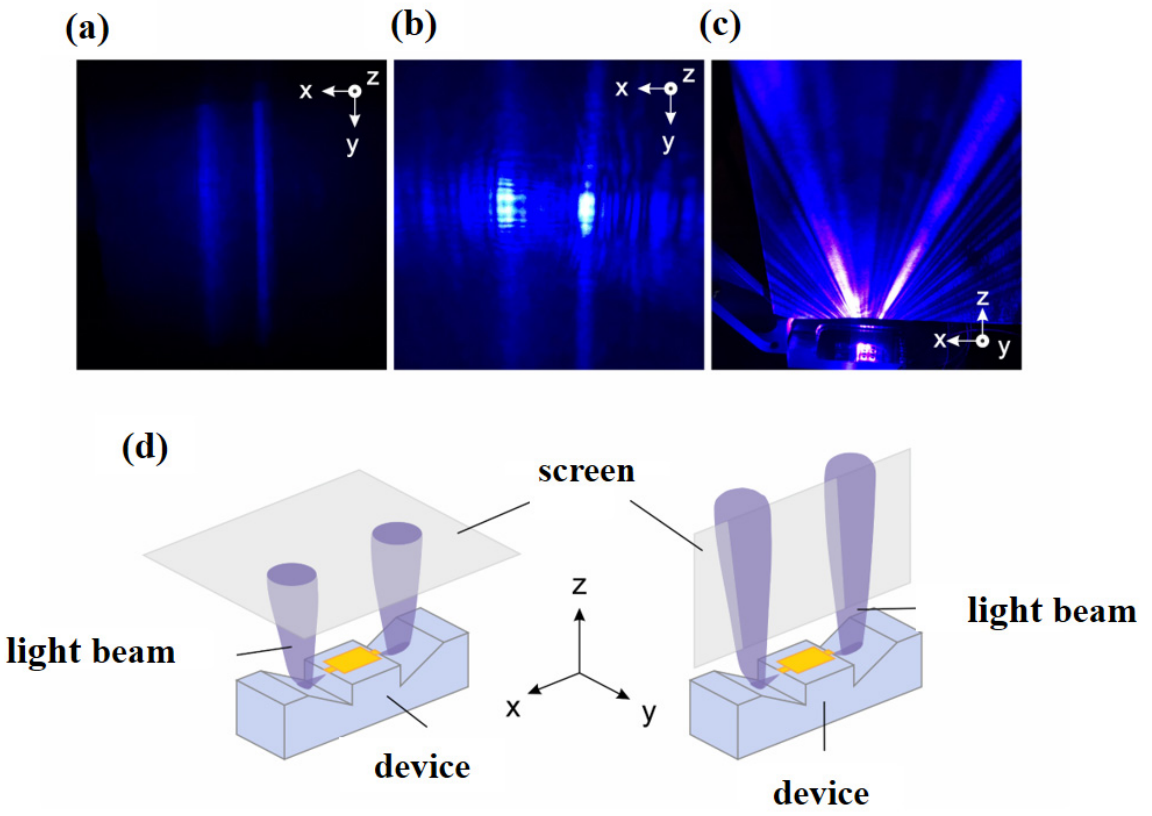
One can see from Figure 11b that in order to keep the center of the output beam within +/ − 10° from the vertical direction, the orientation of the deflecting mirror has to be retained between 40° and 50°. The experimental result presented in Figure 10c showing ror was different from the intended value. Figure 10. Photographic images show the direction of beam emission, ( a ) below laser threshold, ( b ) above laser threshold, ( c ) when the screen is placed in the plane containing the beams and laser waveguide axis, and ( d ) schematic view of how the emitted beams direction was captured in figure ( a – c ).